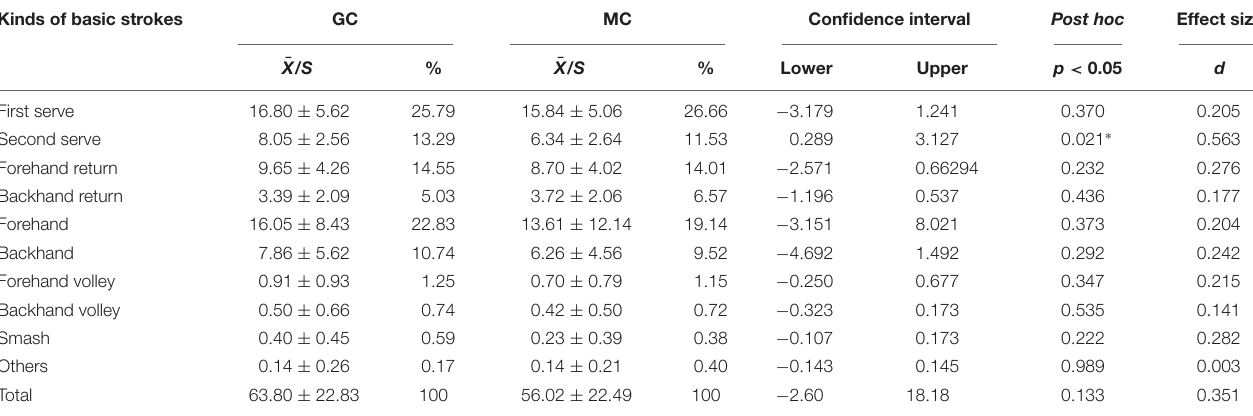
TABLE 2 | Descriptive values (mean, standard deviation, and percentage) and analysis of variance (Student’s t -test for paired samples) of the “kinds of basic strokes” per match. Kinds of basic strokes GC MC Confidence interval Post hoc Effect size